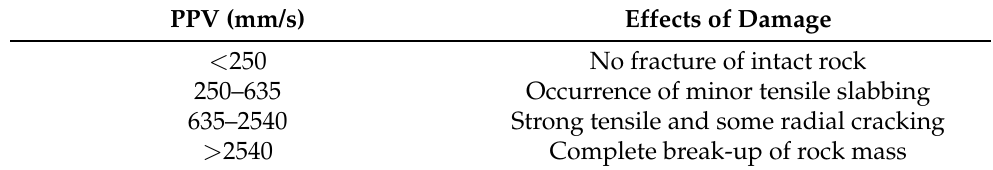
Table 3. PPV-based criteria for blast-induced damage in rock (adopted from Mojtabai and Beattie [53]). Rock Type Uniaxial Strength (MPa) Soft schist Hard schist Shultze granite Granite